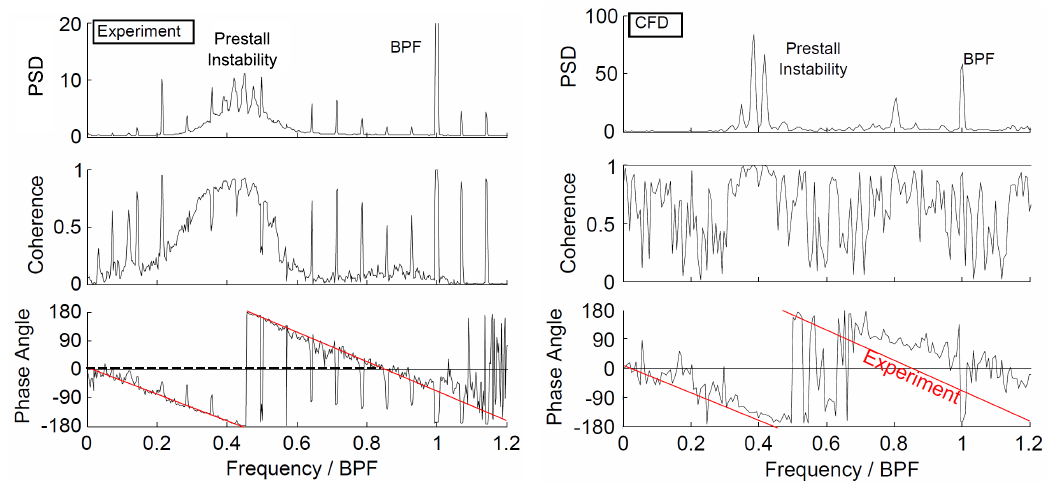
Figure 8. Frequency analysis - comparison between experiment and